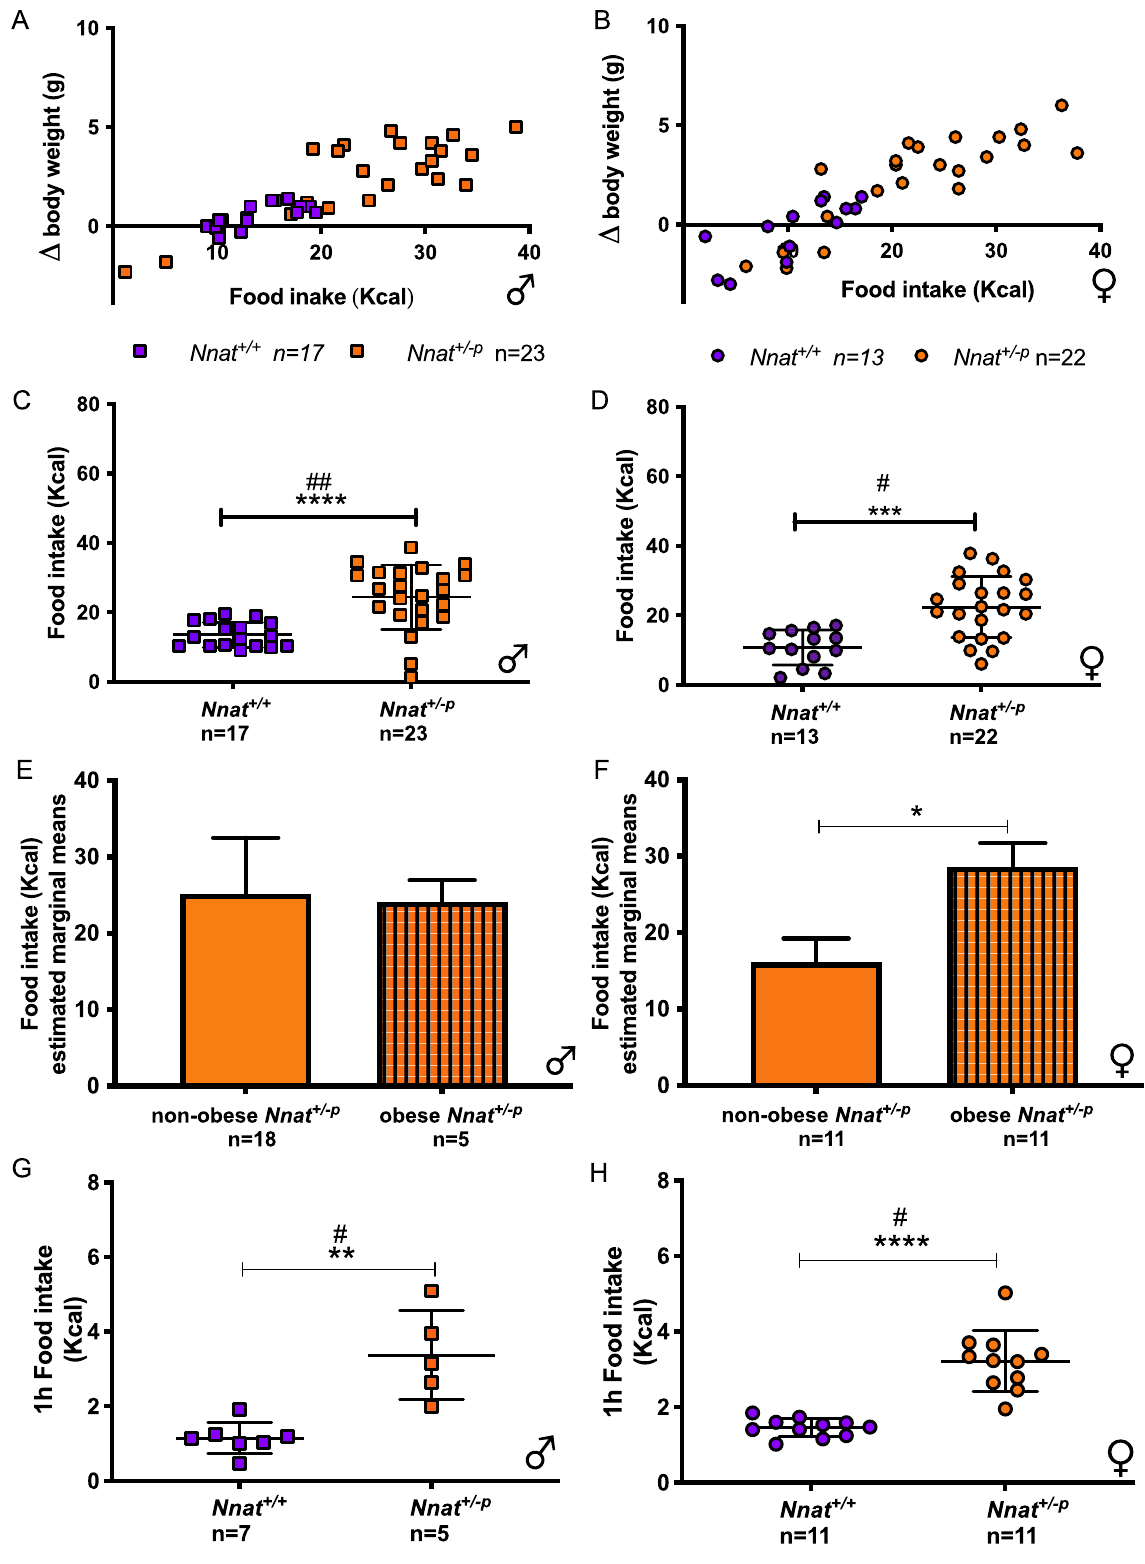
Figure 2. Nnat loss affects food intake. Change in body weight plotted against food intake over 48 h in calorimetry system in male ( A ) and female ( B ) mice fed on standard chow diet. Total food intake in Nnat + / + and Nnat + /−p male ( C ) and female ( D ) mice over 48 h in calorimetry system. ANCOVA analysis of the food intake over 48 h in calorimetry system in males ( E ) and females ( F ). Total caloric intake in the re-feeding protocol in male ( G ) and female ( H ) mice fed condensed milk. Data are expressed as mean ± SD, * P < 0.05; ** P < 0.01; *** P < 0.001; **** P < 0.0001 for Mann–Whitney test and # P < 0.05; ## P < 0.01 for Levine’s